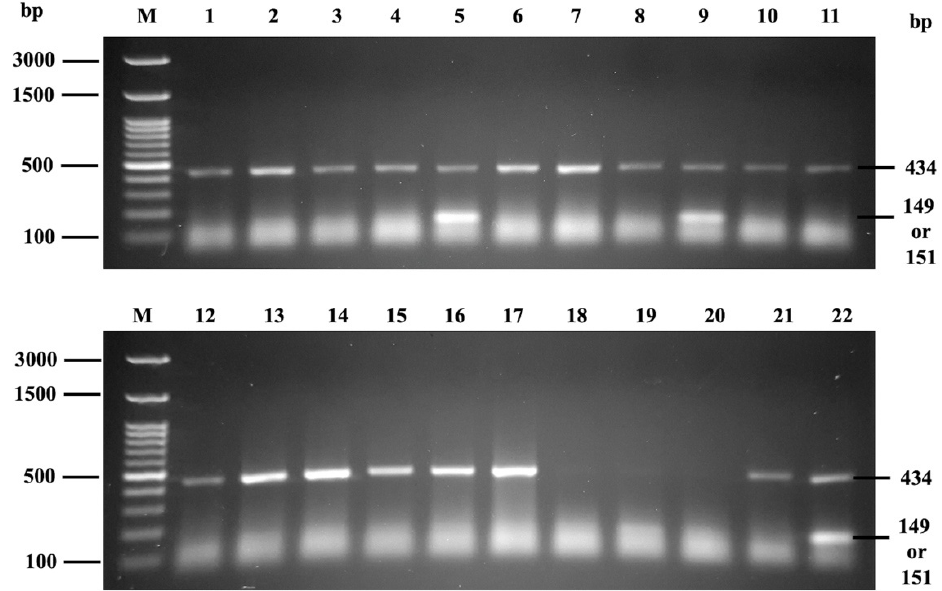
Figure 5. Mi a genotyping by PCR-SSP. Lane M: 100 ladder (Biotech rabbit, Germany), Lane 1–4, 6–8, 10–17: Mi a negative. Lane 18–19: Poor DNA template. Lane 5, 9: Mi a Positive. Lane 20: Non template DNA (NTC). Lane 21: Negative control (NC) and Lane 22: Positive control (PC).